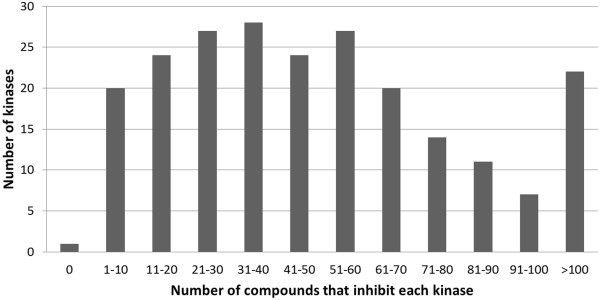
Distribution of the number of kinases as a function of compounds inhibiting the respective number of kinases. Compounds that lowered bioactivity of the kinase in question by 50% or more were considered active. Overall, kinases in the dataset were inhibited by 1 to 70 compounds in most cases. This indicates that our kinome dataset contains a wide range of kinases, including those that are promiscuous to multiple compounds as well as selective kinases.